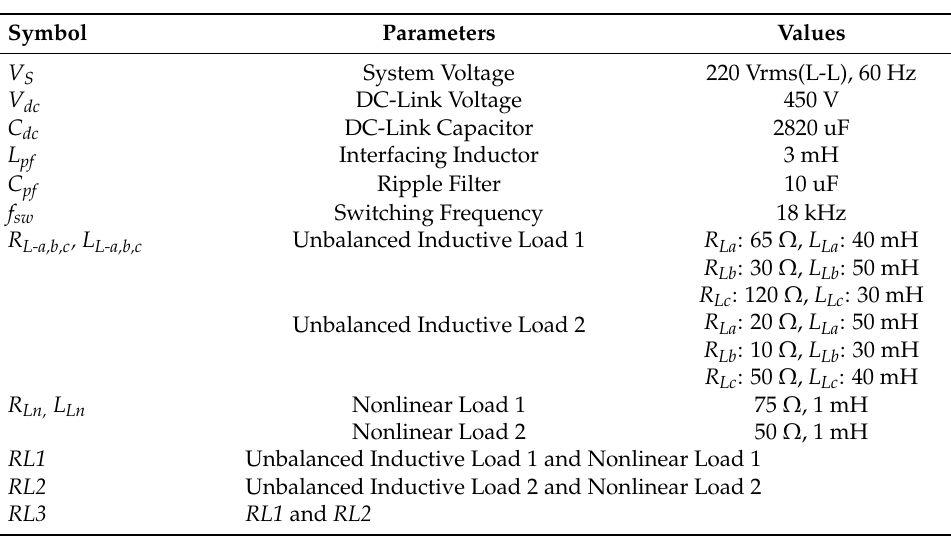
Figure 4. DSP-based DSTATCOM platform. ( a ) Hardware block diagram of DSTATCOM in distribu- tion system; ( b ) Photo of experimental setup. Table 1. Specification of DSP-based